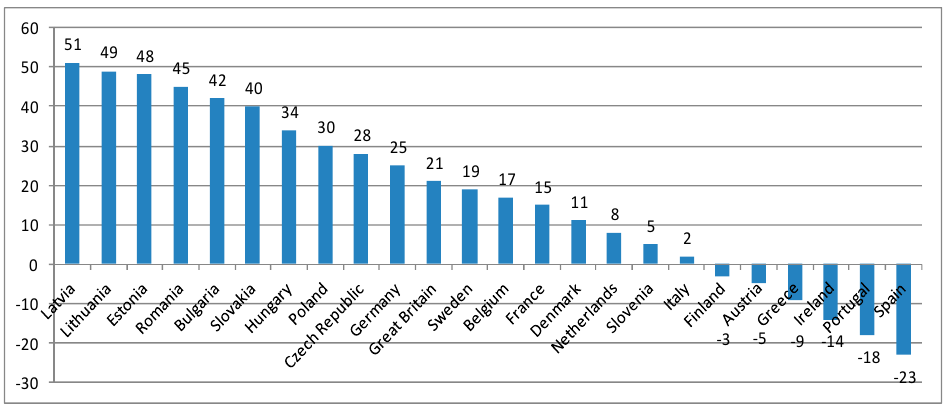
Figure 12. Implementation of greenhouse gas reduction commitments by 2030. Implementation status in 2018 (in terms of percentage) [41,52].